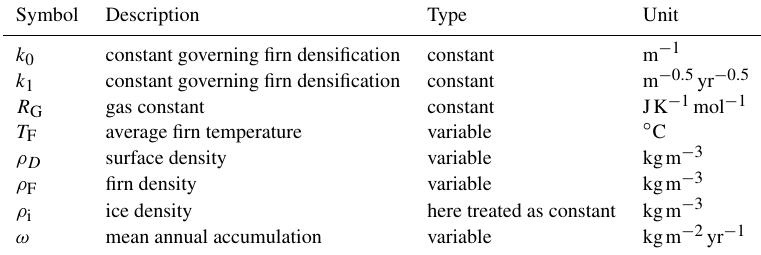
Table B5. List of the symbols used in HL.